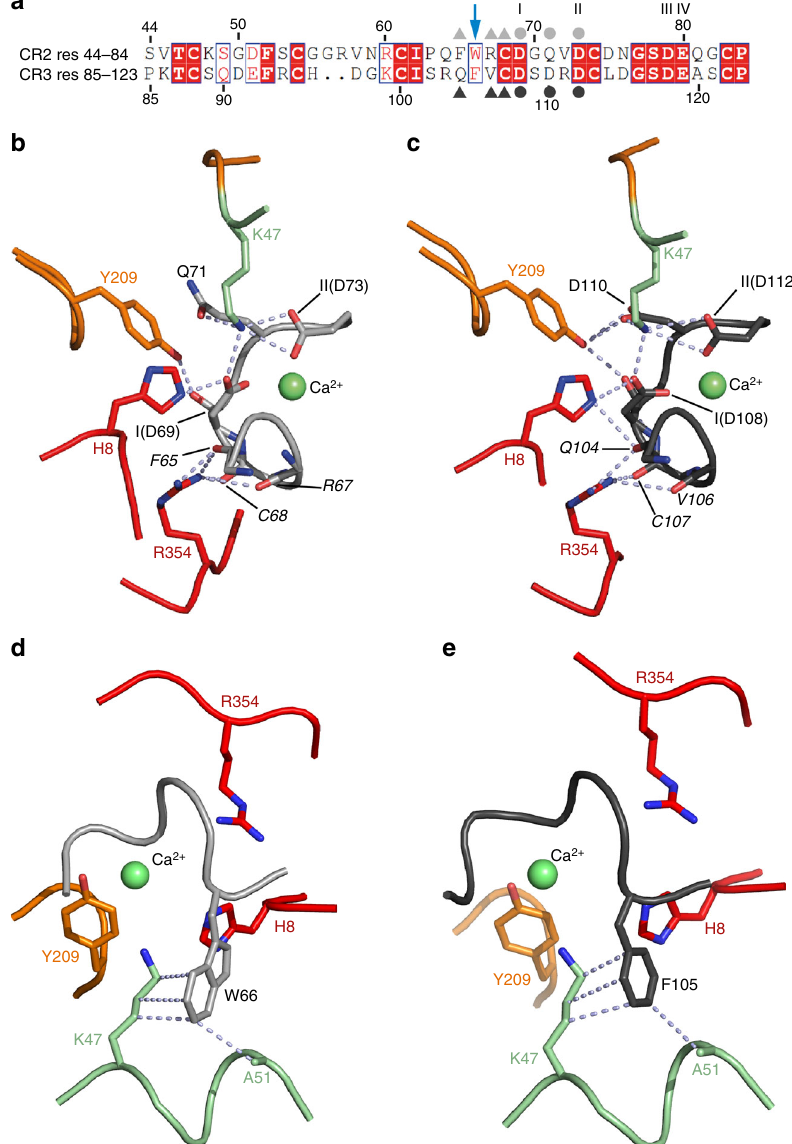
Fig. 4 Molecular basis of G/CR interaction. a Sequence alignment of LDL-R CR2 and CR3. Conserved residues are in a red box and similar residues are shown by red letters boxed in blue. Acidic residues involved in the binding of the Ca 2 + ion are indicated by I, II, III, and IV. CR residues involved in polar contacts with G are labeled with gray symbols (light gray for CR2 and dark gray for CR3; dots when the contact is established via the lateral chain and triangles when the contact is established via the main chain) on each CR sequence. The aromatic residue which protrudes from the CR modules and establishes hydrophobic interactions with G is indicated by a blue arrow. b , c Close-up view on the G th -CR interface showing the docking of G basic residues on the acidic patch of both CR2 ( b ) and CR3 ( c ). In both cases, the same G residues (H8, K47, Y209, and R354) are involved in the interaction. Residues labels on each CR domain are in italic letters when the contact is established via the main chain; putative bonds are shown as light blue dashed lines. d , e Close-up view on the G th -CR interface showing the hydrophobic interactions between the aromatic residue W66 of CR2 ( d ) and F105 of CR3 ( e ) and residues K47 and A51 of G.The color code is the same as in Fig. 3a and